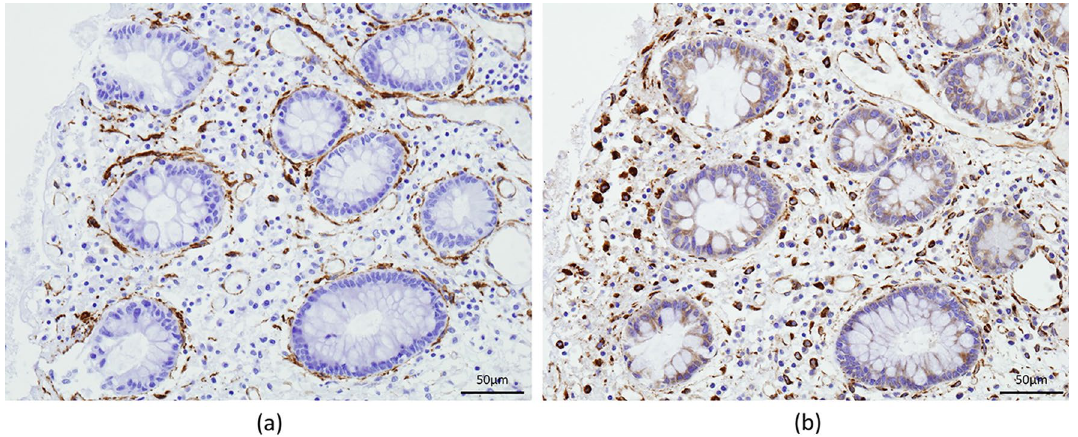
Figure 6. Immunostaining for α smooth muscle actin and HSP47. Representative immunohistochemical staining images for HSP47 and smooth muscle actin in 3-µm-thick serial sections of intestinal biopsy tissues obtained from patients with Crohn’s